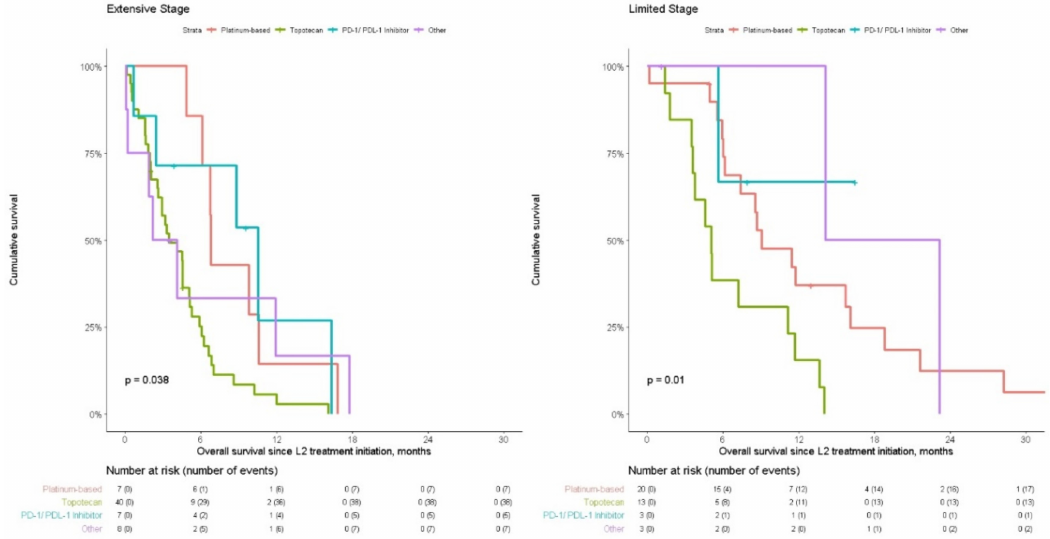
Figure 1. Overall survival from L2 initiation for patients that initiated L2 by treatment, split by extensive (n = 62) and limited (n = 39)